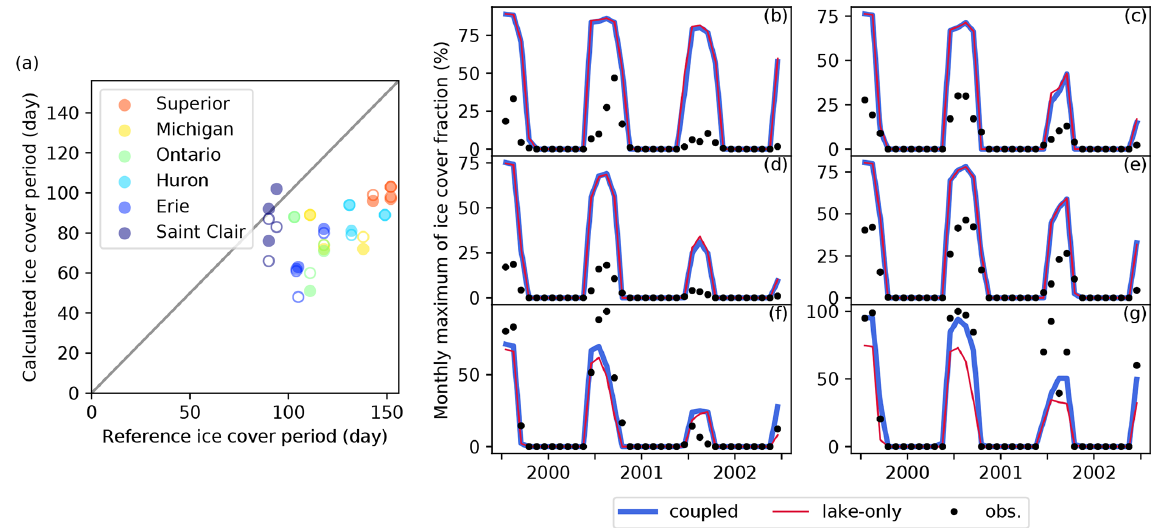
Figure A1. The comparison of (a) the ice cover period in each year (day), and (b–g) the monthly maximum of the ice cover fraction (%) in the Great Lakes region between the simulations and the reference dataset for (b) Lake Superior, (c) Lake Michigan, (d) Lake Ontario, (e) Lake Huron, (f) Lake Erie, and (g) Lake St. Clair (HydroLAKES ID 5, 6, 7, 8, 9, and 66, respectively). (a) The filled (hollow) dots show the results of the coupled (lake-only) simulation. (b–g) Black dots show observed values, and the blue (red) lines show values simulated by the coupled (lake-only)